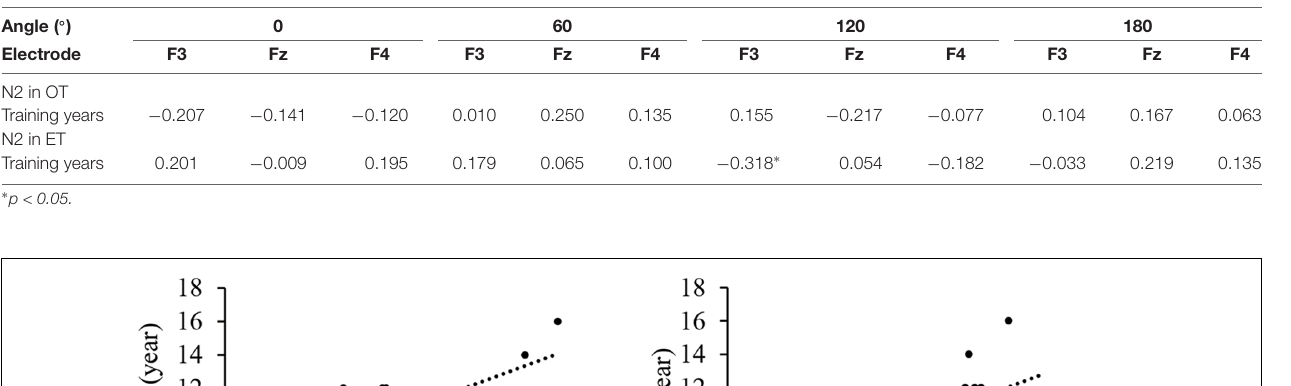
TABLE 5 | Values of correlation coefficients between N2 amplitude and training years in OT and ET conditions.